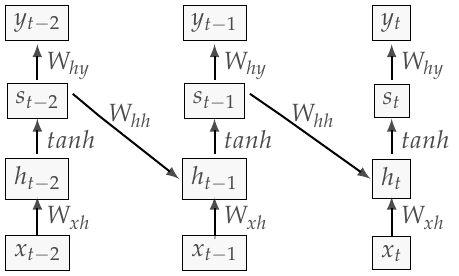
Figure 2. RNN multiple sequence propagation structure.